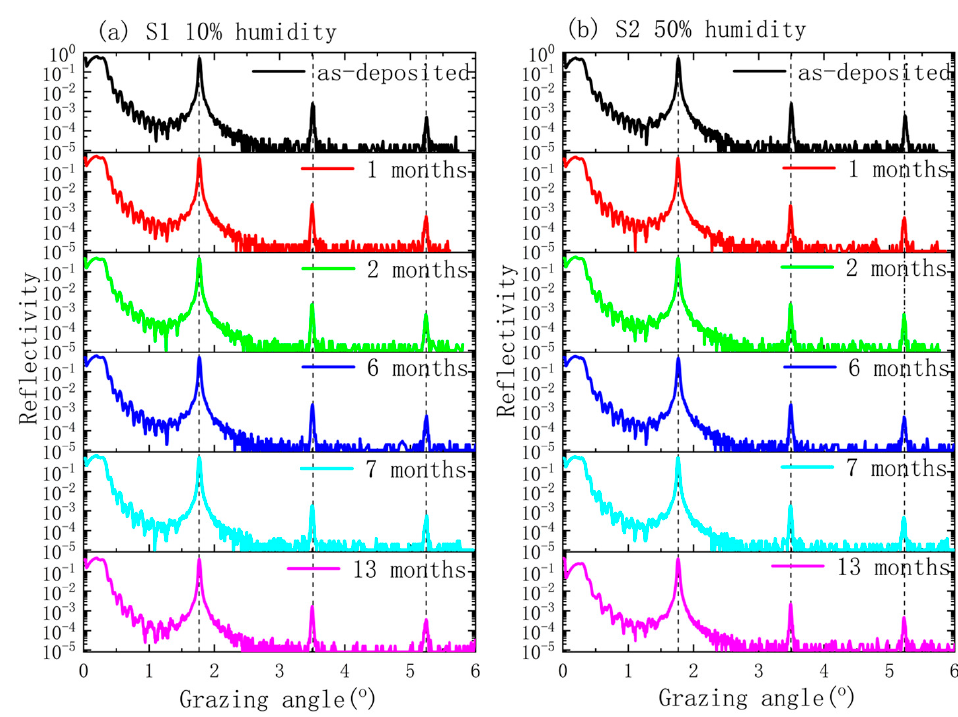
Figure 1. X-ray reflectometry (GIXR) curves of the Pd/B 4 C multilayers: ( a ) sample S1 stored at 10% humidity and ( b ) sample S2 stored at 50% humidity.